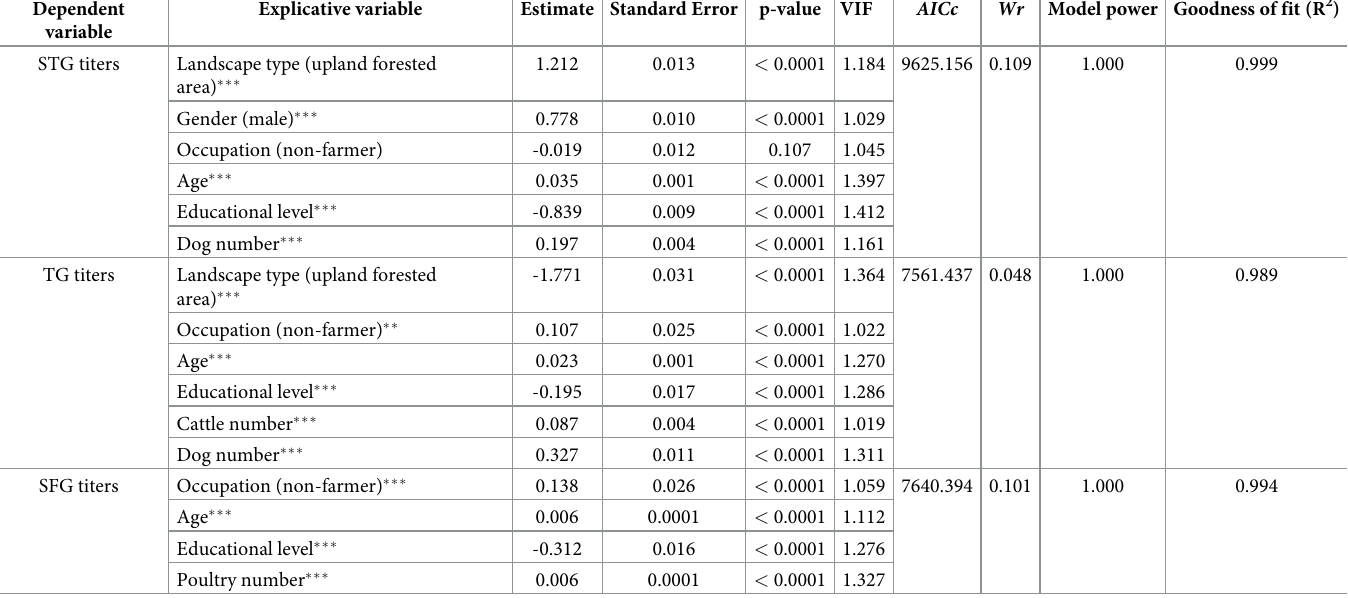
Table 2. GLM best model selections after 1,050 total computed models based on AICc to determine socio-demographic and environmental factors explaining level of STG, TG and SFG past exposures in the study area. Similar initial models are applied comprising with the following variables: Landscape type, Gender, Occupation, Age, Educational level, Dog number, Cat number, Pig number, Poultry number and Cattle number (with Poisson distribution after checking data distribution using “fit- distrplus” package in R freeware). Analysis of deviance (type II test) significant level for each variable is indicated as following: � p = 0.05–0.01; �� p = 0.01–0.001 and ��� p < 0.001. VIF = Variance inflation factor; Wr = Akaike’s weights.